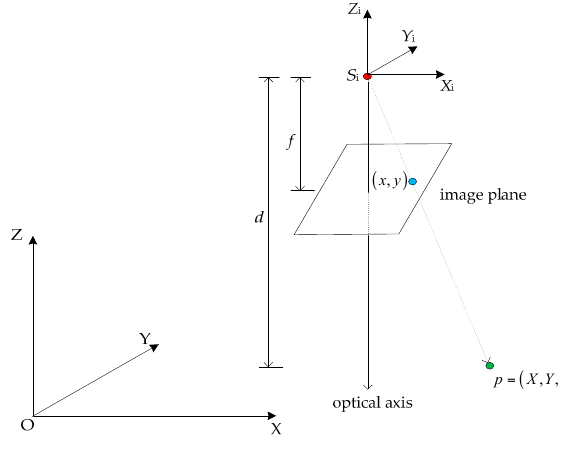
Figure 4. Illustration of projection model of RGB-D camera.